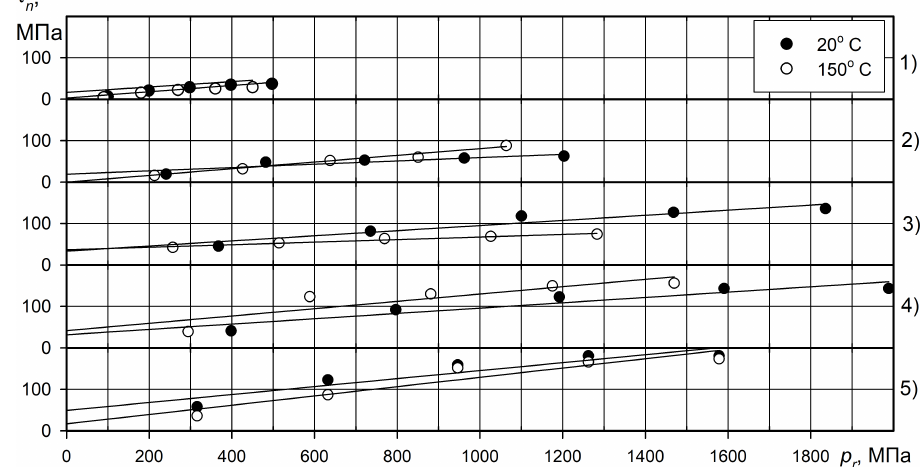
Figure 9: The dependence of the strength of the adhesive bond shear from normal stress on the contact: 1) Cu-0,55Cr-0,2Cd-0,02Zr (1050 ∘ C, 1 h) – P6M5; 2) Cu-1Cd (industrial processing) – P6M5; 3) Cu-1Cr-0,05Zr (industrial processing) – P6M5; 4) Cu-0,55Cr-0,2Cd-0,02Zr (1050 ∘ C, eight ECAP cycles) – P6M5; 5) Cu-0,55Cr-0,2Cd-0,02Zr (1050 ∘ C, eight ECAP cycles, 400 ∘ C for 1 h) –